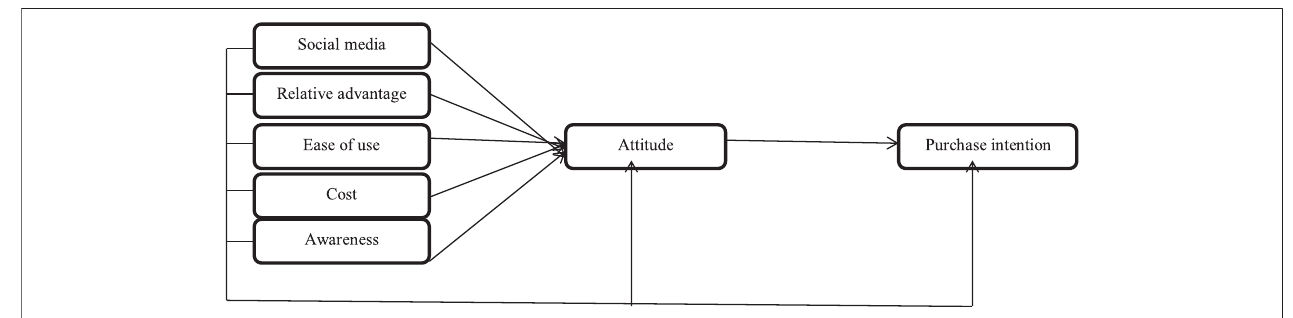
FIGURE 1 | The conceptual framework is based on a survey of the literature. The research found that social media, relative advantage, ease of use, cost and awarenesswillin fl uencepurchaseintentionwiththeindirecteffectofattitude.Thisstudyconsidersthatsocialmedia,relativeadvantage,easeofuse,costandawareness also directly impact consumer attitude. These components have radically altered attitude towards purchase